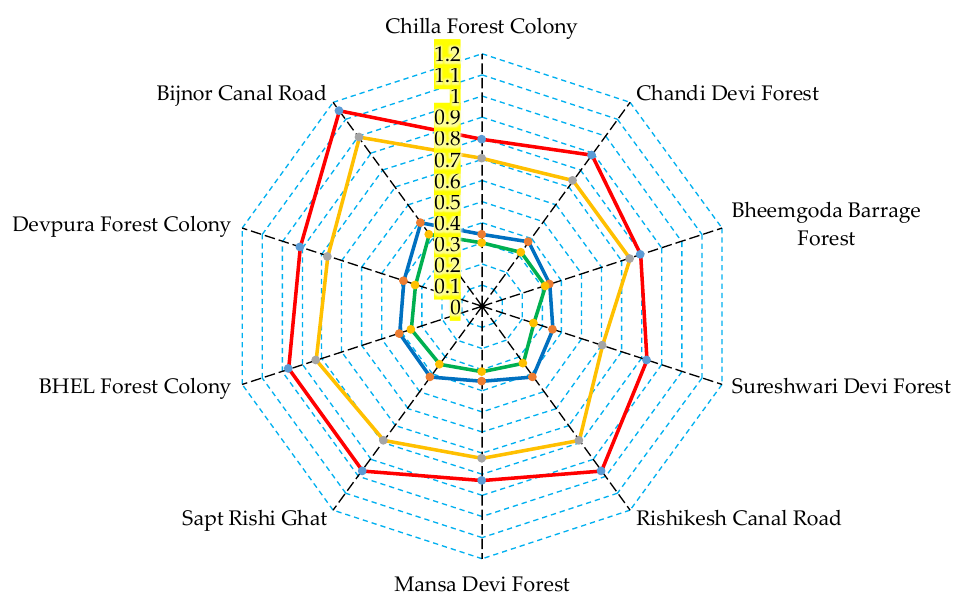
Figure 4. Spider-web diagram showing the health risk index (HRI) values of heavy metal contents in two oyster mushroom spp. (PO: P. ostreatus and PD: P. djamor ) collected from different locations of Rajaji National Park, Haridwar, India.